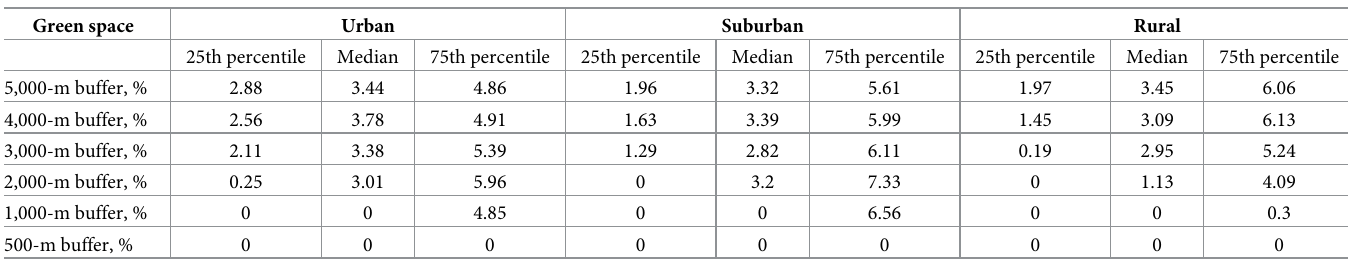
Green space was defined as seminatural, forested, blue, and urban green areas based on CORINE Land Cover 1990 (European Environment Agency). CORINE, Coordination of Information of the Environment.